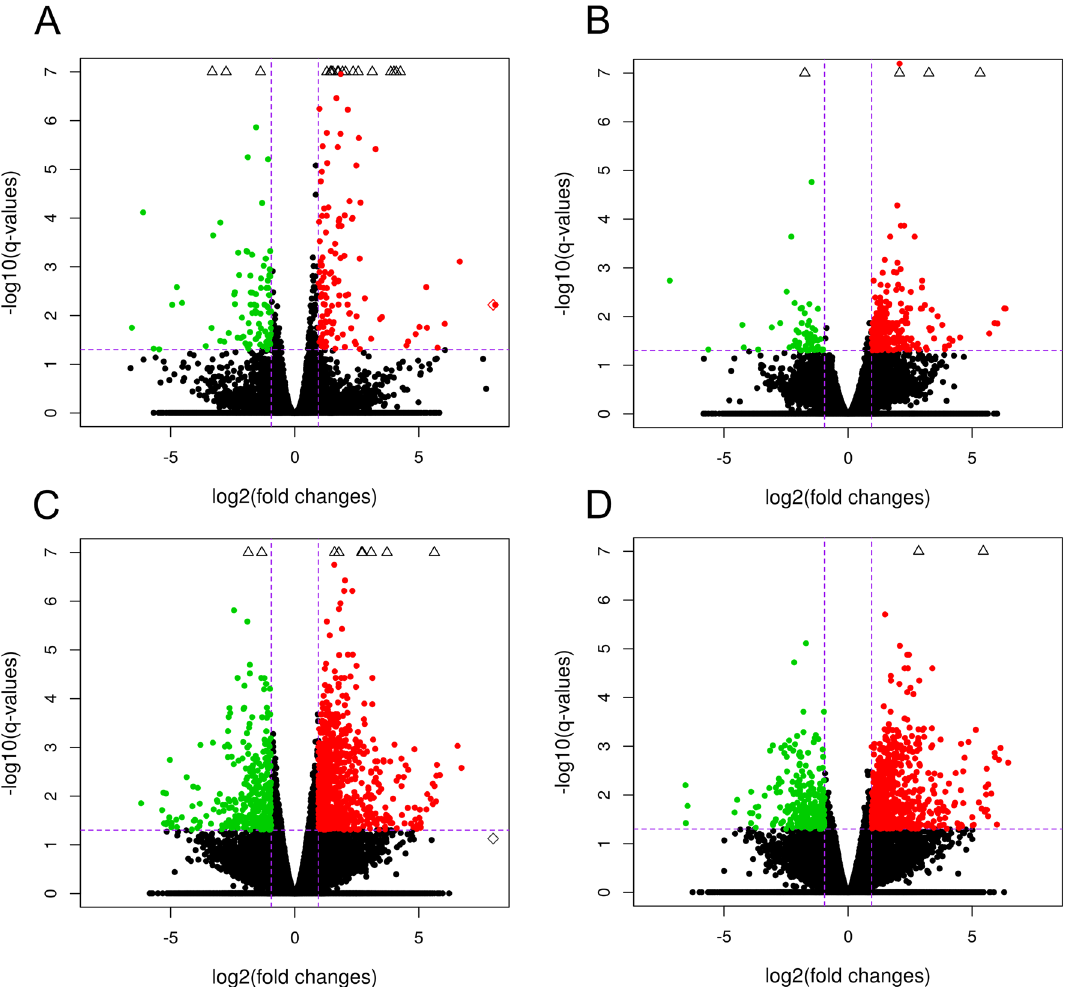
Figure 1. Volcano plots describing the abundance of transcript expression profiles after LPS treatment ( A ); the impact of PPARγ agonists—PGJ 2 ( B ) or pioglitazone ( C ) and antagonist ( D ) on LPS action in endometrial tissue. Logarithmic fold changes in expression (log 2 FC) are plotted on the X-axis against normalized adjusted p -values (Y-axis). The sharp horizontal line denotes the negative logarithmic adjusted p -value (0.05) cut- off. Sharp vertical lines denote the fold change cut-off (absolute value of log 2 FC > 1). Points represent gene expression values, where green (underexpressed) and red (overexpressed) points denote significant genes (adjusted p -value < 0.05). Grey dots indicate non-significant genes. The plots were generated in base and ggplot2 R bioconductor